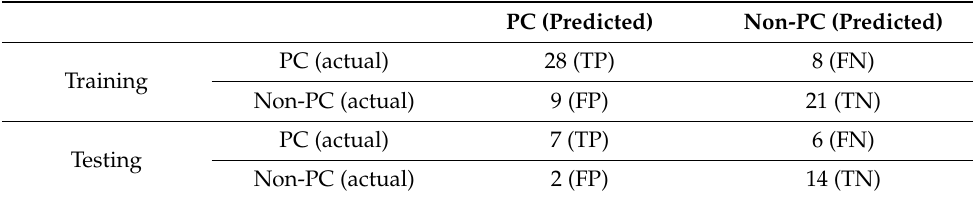
Table 4. Confusion matrix for the SVM.